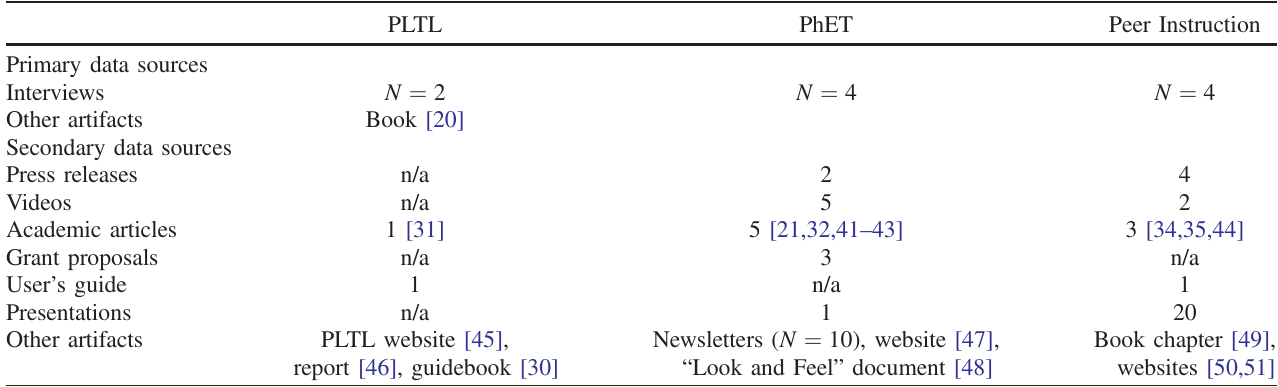
TABLE III. Summary of data sources used in the studies of well-propagated